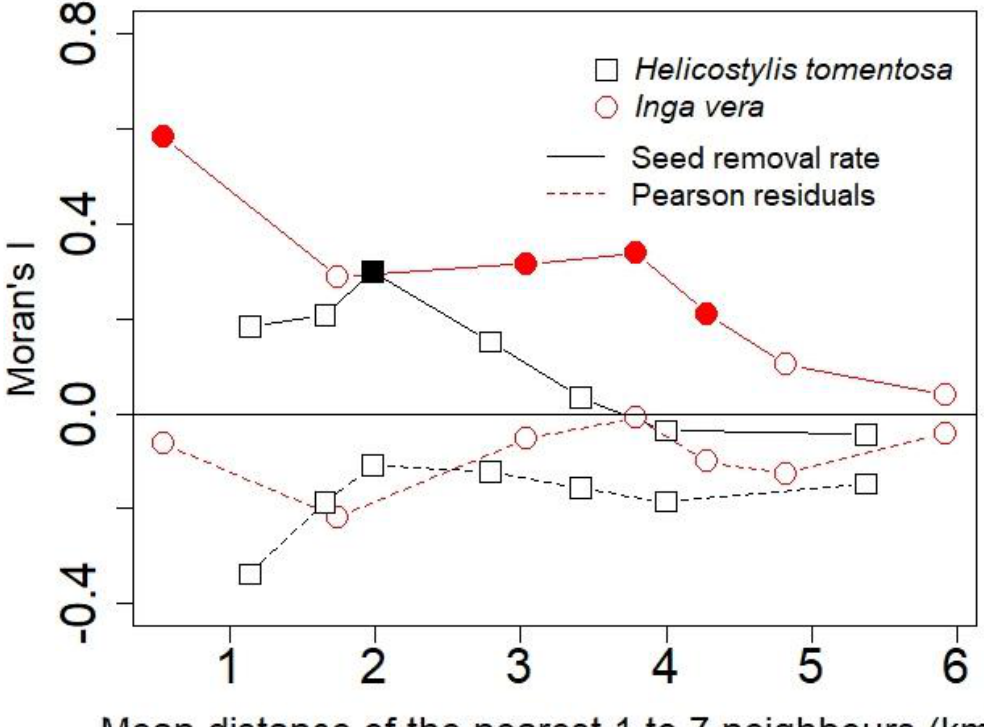
Figure 3. Moran’s I for seed removal rates and Pearson residuals of the auto-covariate logistic regression models computed as a function of the number k of neighbors (accounted for k = 1 to 7, from left to right) and expressed as a function of corresponding mean distance. Significant values for p ≤ 0.05 are in solid symbols and non-significant values in hollow symbols.